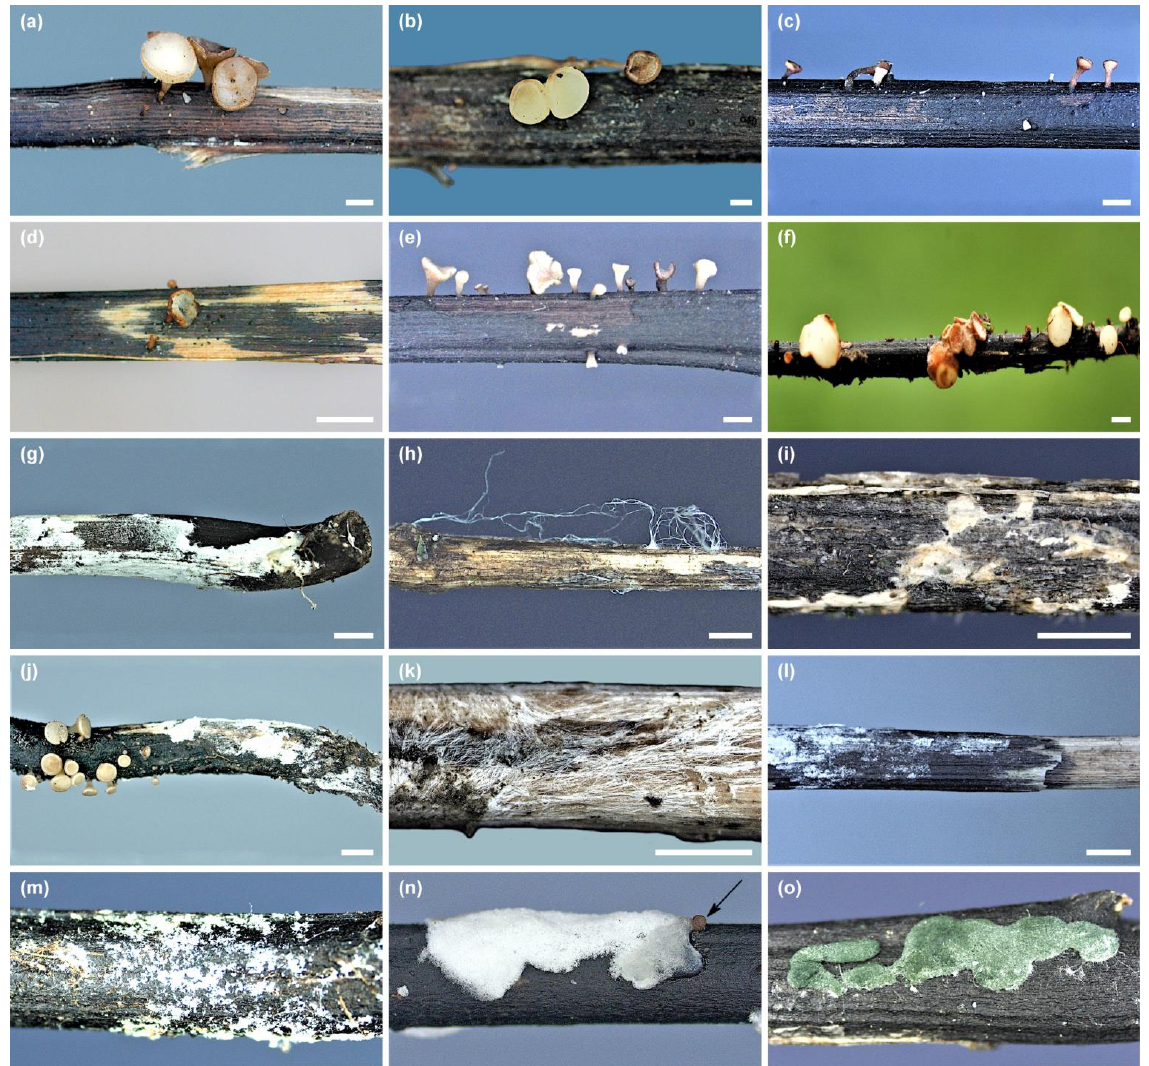
Figure 2. Previous year ash petioles with developed in situ apothecia and pseudosclerotial plates of Hymenoscyphus fraxineus : ( a – f ) apothecia with degrading symptoms colonized by: ( a ) Clonostachys rosea Fe886F, ( b ) Minimidochium sp.1 Fe173F, ( c ) Fusarium sp. 1 Fm409E, ( d ) Trichoderma atroviride Fe377E, ( e ) Trichoderma harzianum Fm506K ( f ) Trichoderma harzianum Fe412E; ( g – o ) pseudosclerotial plate covered with mycelium of: ( g ) Cyathus olla Fe141F, ( h ) Efibula sp. 1 Fe287F, ( i ) Gymnopus sp. 1 Fe1035F, ( j ) Polyporales sp. 1 Fe302F, ( k ) Polyporales sp. 1 Fe1011F, ( l ) Pestalotiopsis sp. 1 Fe447K, ( m ) Trichoderma atroviride Fe57K, ( n ) Trichoderma polysporum Fe166F—mycelium and dead apothecium (arrow), and ( o ) Trichoderma sp. 1 Fe462K; scale bar = 2 mm.